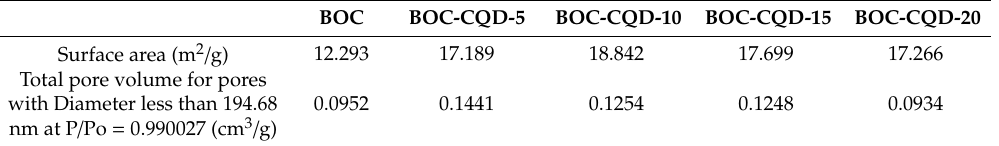
Table 1. Specific surface area of BOC and CQD / BOC.